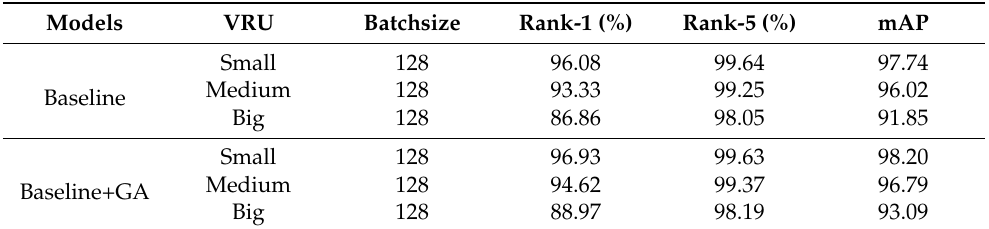
Table A4. Test results of the baseline model and the global attention model with input batch 128 on the VRU dataset.